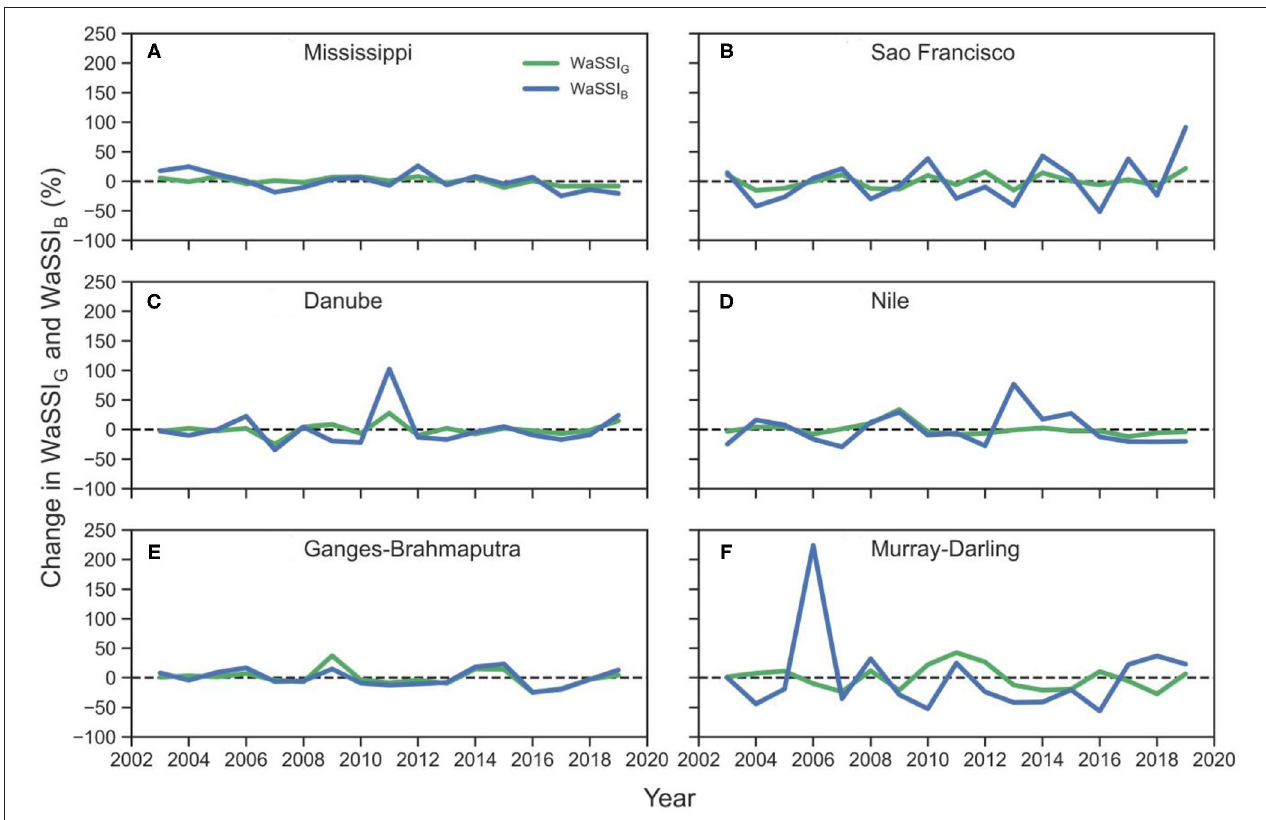
FIGURE 3 | Anomalies (percent deviation from average value) of green (WaSSI G ) and blue (WaSSI B ) water supply stress indices across study basins including Mississippi (A) , Sao Francisco (B) , Danube (C) , Nile (D) , Ganges-Brahmaputra (E) , and Murray-Darling (F) from 2003 to